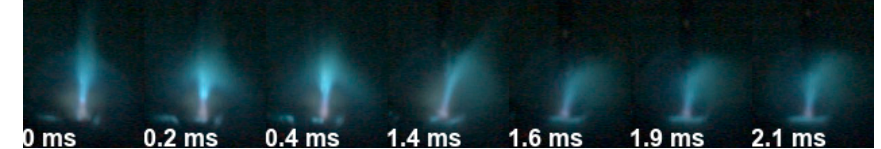
Figure 4. CMT rare patter, occurred at the start of the ignition.